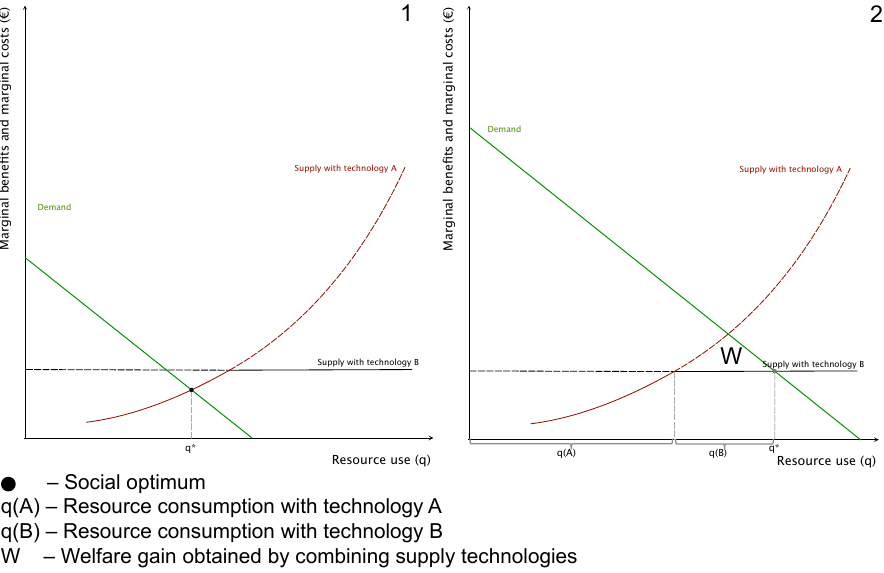
Figure 1. Welfare impacts caused by the implementation of a circular economy strategy for phospho- rus